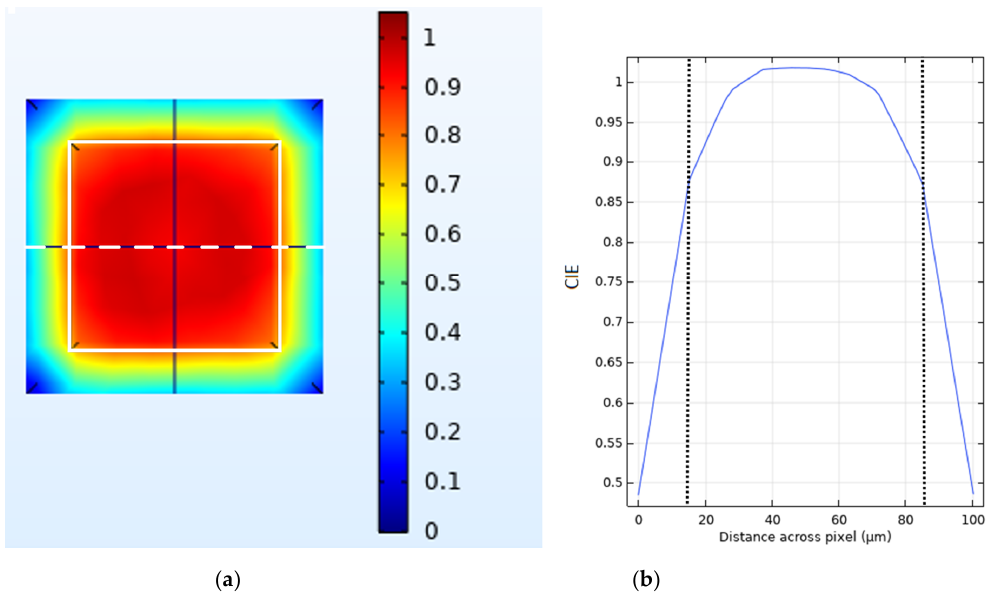
Figure 14. ( a ) Heat map representing charge induction efficiency (CIE) across a single pixel as generated and viewed in COMSOL. The plot represents a cut through taken perpendicular to the incident photon flux. The edges of the anode are marked by the white square superimposed on the image. ( b ) A plot of CIE vs. distance along a path taken across the centre of the pixel (the horizontal dashed white line in Figure 14a).